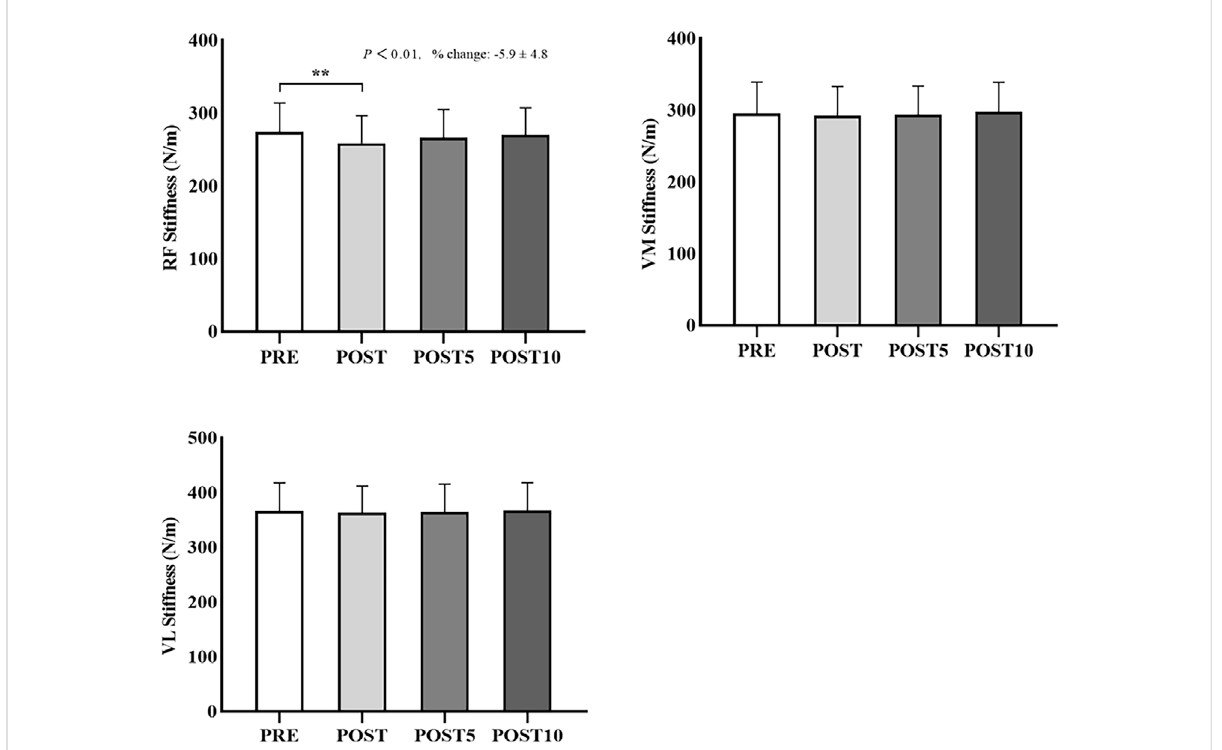
FIGURE 3 Stiffness changes of the rectus femoris (RF), vastus medialis (VM), and vastus lateralis (VL) muscles before (PRE) and immediately after static stretching (POST), or 5 (POST 5) and 10 (POST 10) min after static stretching. pp p <